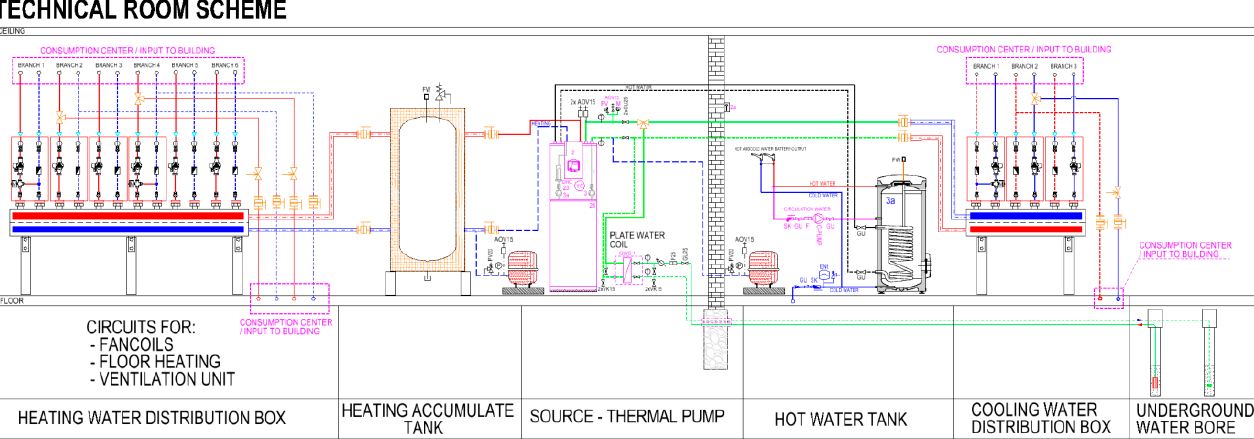
Figure 5. Monitored room with the measuring instruments.